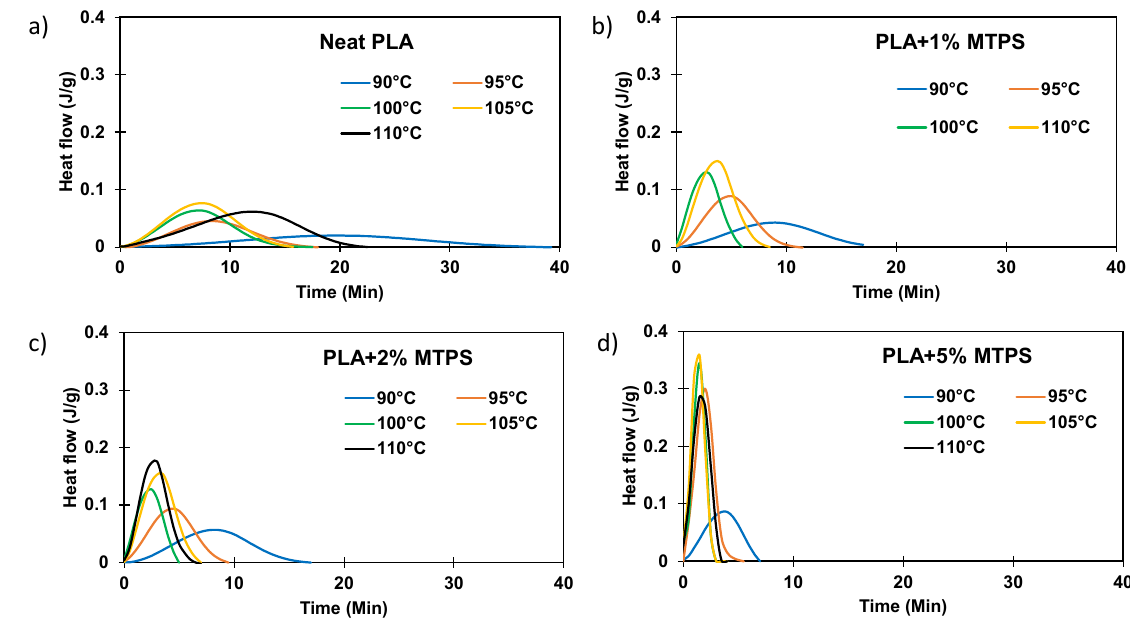
Figure 10. DSC melting thermograms of ( a ) PLA and blends ( b ) PLA + 1%MTPS, ( c ) PLA + 2%MTPS, ( d ) PLA + 5% MTPS at various temperatures.